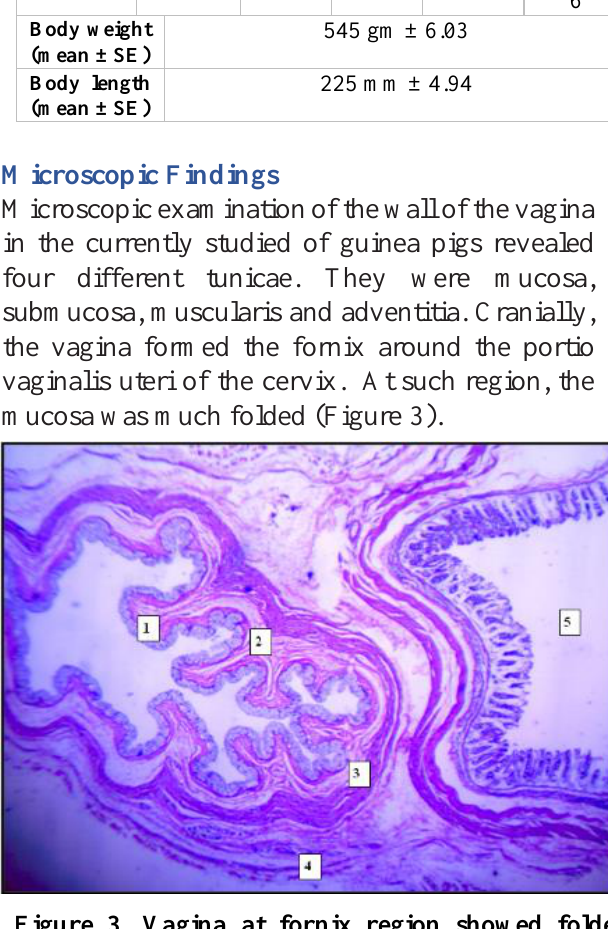
Figure 3. Vagina at fornix region showed folded mucosa lined with simple columnar mucous epithelium (1), propria-submucosa (2), internal layer of tunica muscularis (3), external layer of tunica muscularis (4), colon (5). 25X, H&E